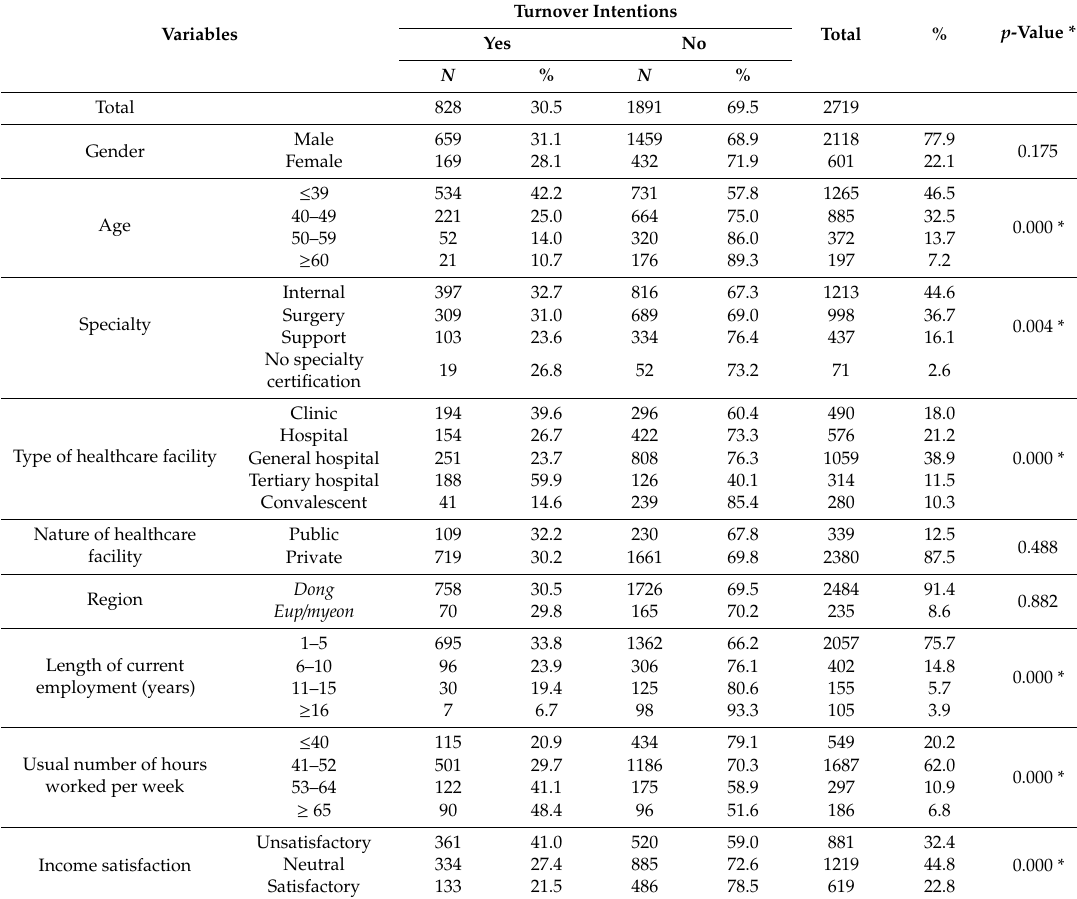
Table 1. Variation in turnover intentions in the analyzed variables ( n =